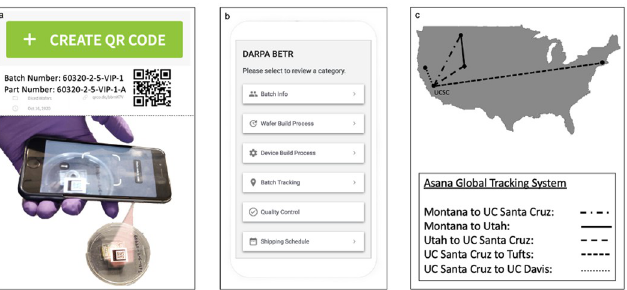
Fig 1. Tracking system overview. (a) Generate QR Code on subscription-based desktop application and label device container with unique identifier and QR Code. Scan QR Code to access data. (b) Data accessed focuses on the following categories: batch info, build process, batch tracking, quality control, shipping schedule, and sample testing. (c) Data from the QR codes tracking system is implemented into Asana, a global tracking system that we customized to provide device data traceability amongst five universities. Asana tracks the location and transit of the device across the different collaborating institutions. This tracking is important for inventory management to make sure that there are always enough devices at each step and location so that the subsequent fabrication step or experiment is not delayed. Fig 1b provided through courtesy of QR Code